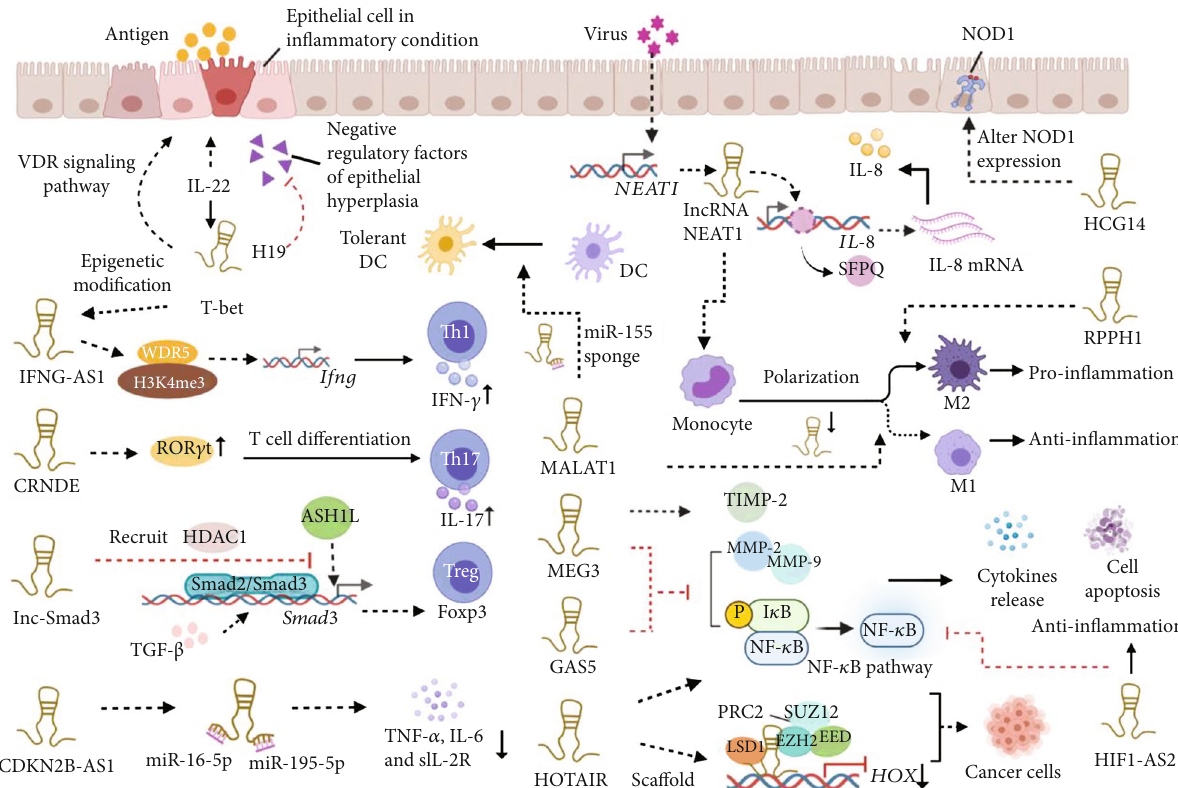
Figure 1: Functions of exosomal lncRNAs on intestinal mucosal immune system. Exosomal lncRNAs promote Th17 cell di ff erentiation and IFN- γ secretion of Th1 cells, regulate the polarization of Treg cells and macrophages, reprogram DCs into a tolerant phenotype, a ff ect the cytokine secretion and in fl ammatory signaling pathways, and participate in immune response and immune evasion of cancer